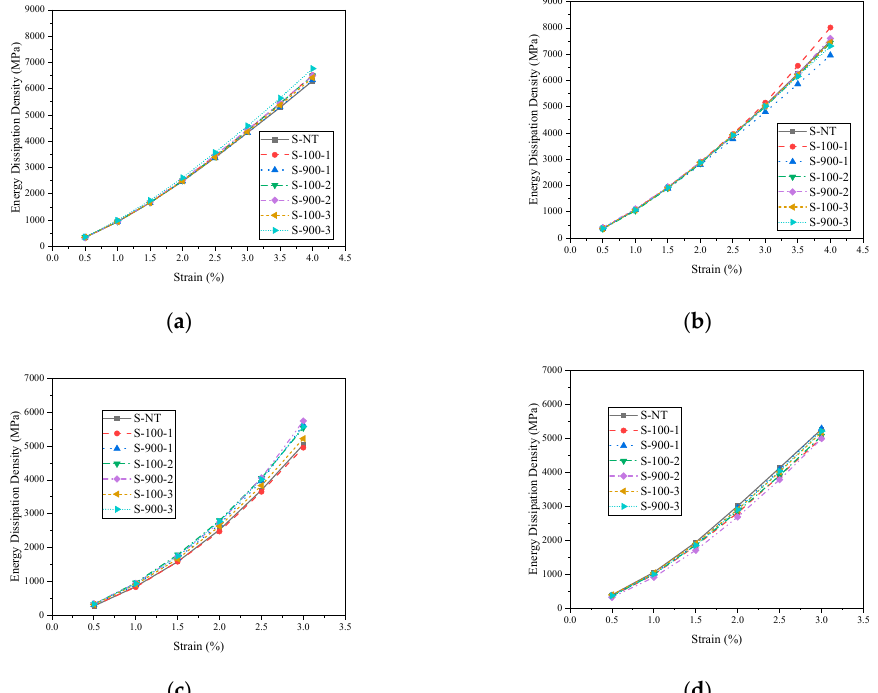
Figure 19. Energy dissipation density. ( a ) Q235; ( b ) Q345; ( c ) S304; ( d ) S316.